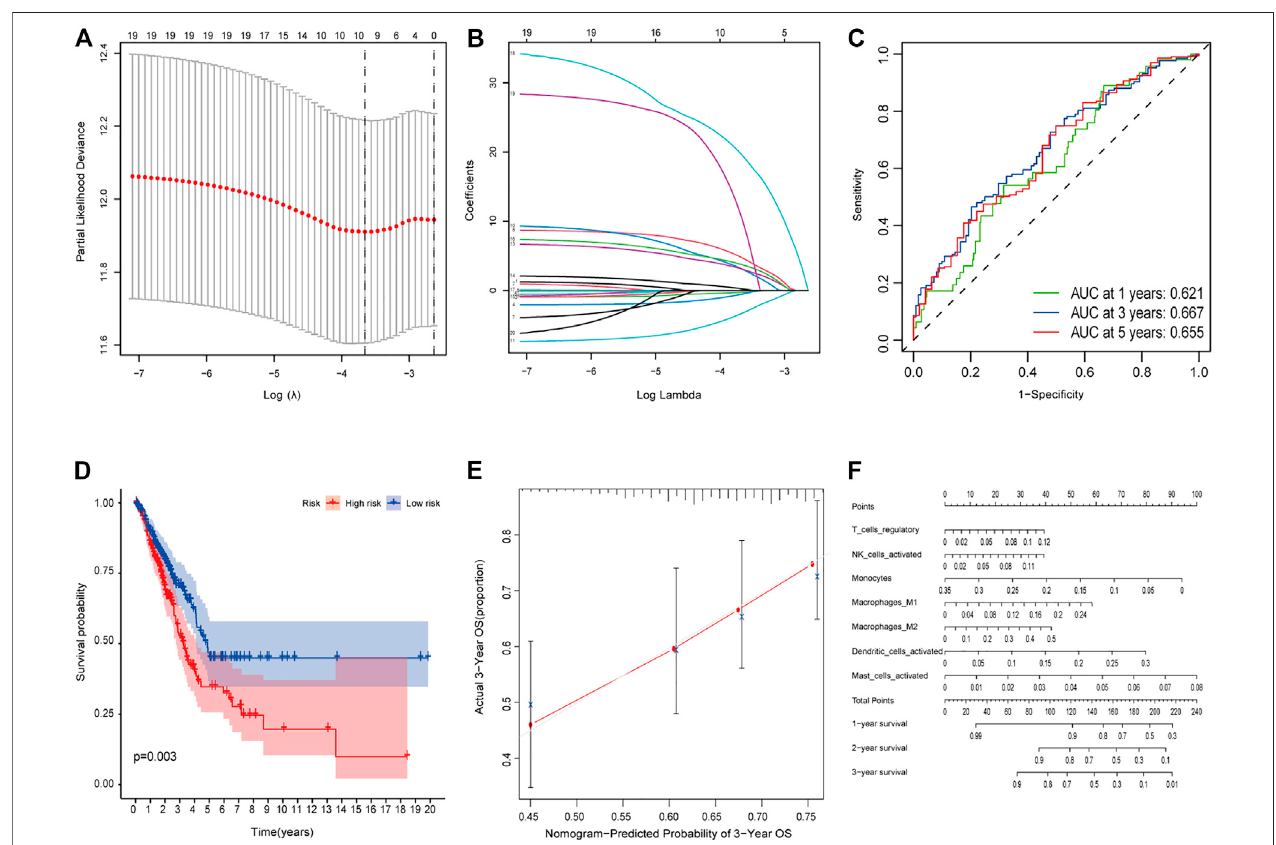
FIGURE 5 | (A – E) Model diagnosis process Lasso regression and ROC curves which were constructed by patterns of tumor-in fi ltrating immune cells. (F) Nomogram. ROC, receiver operating characteristic curve. * p < 0.05.